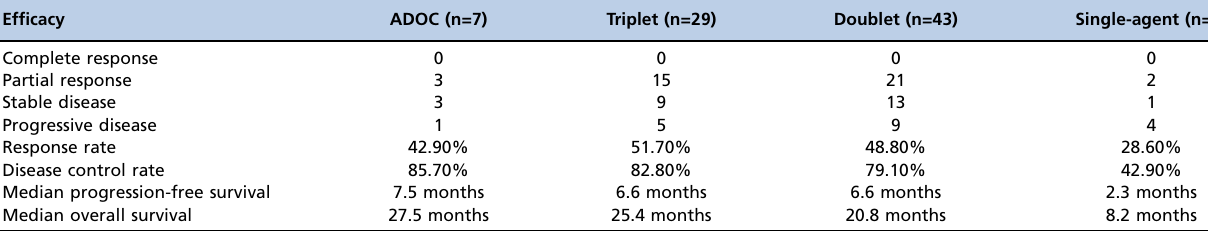
Table 2 - The efficacy of different regimens.